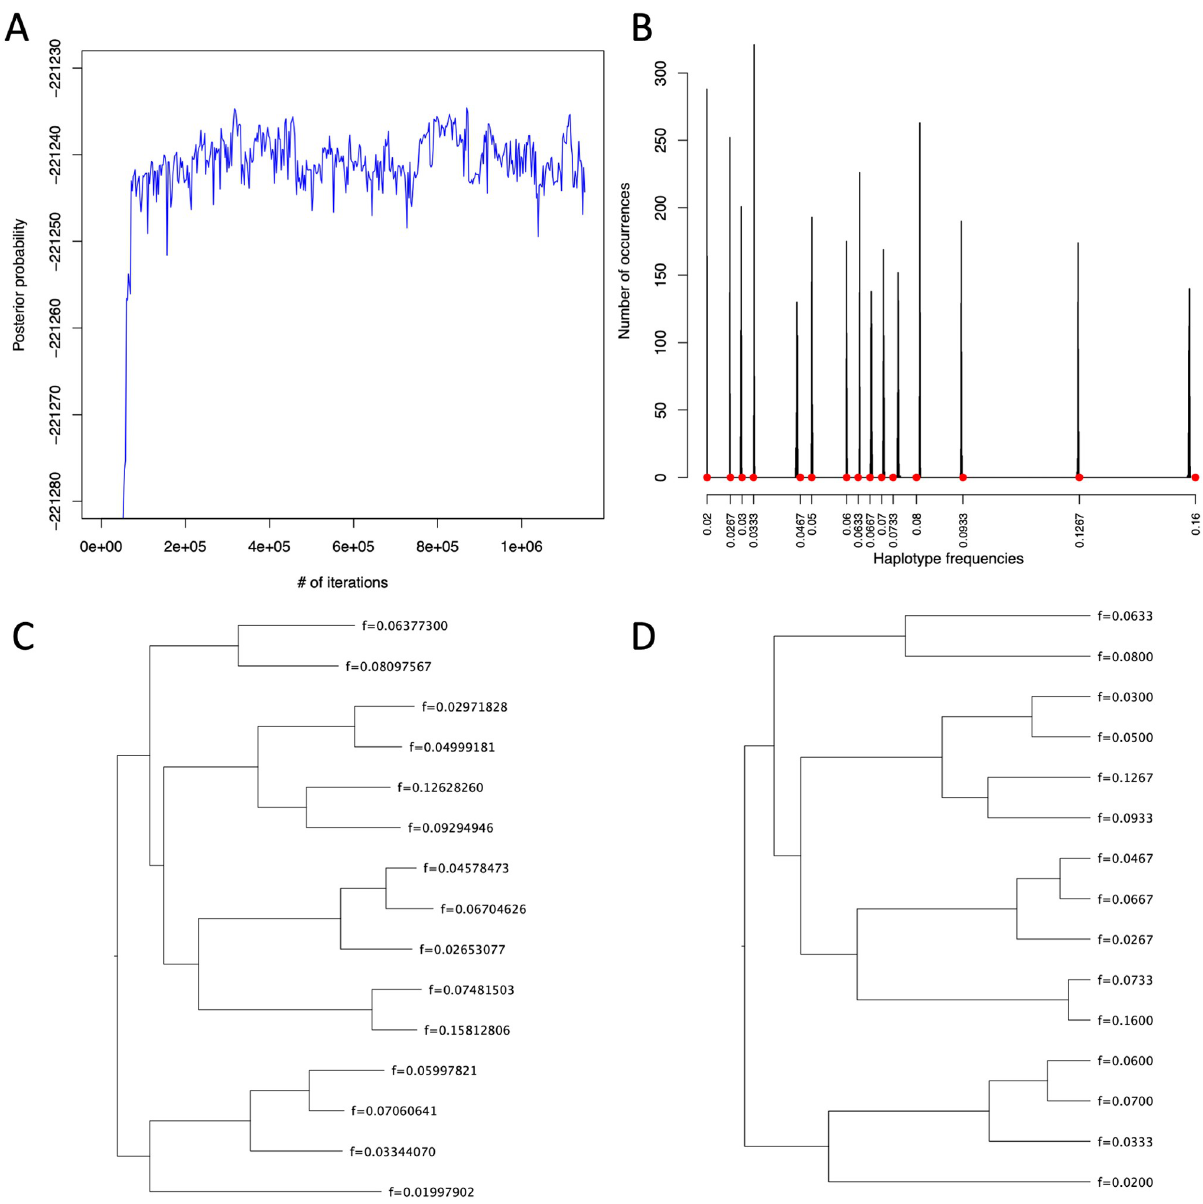
Fig 4. The result of AFPhyloMix on a simulated data set with a mixture consisting of 15 sub-samples. AFPhyloMix was run under the default settings on the read alignments of a simulated mixture of 15 sub-samples in order to estimate the tree topology and the tip relative abundances. (A) The posterior probabilities along the cold chain of MCMCMC process while running the AFPhyloMix, which increased rapidly during the burn-in period and then frustrated steadily over a range of values and was reaching a convergence. (B) The distribution of tip relative abundances (i.e. sub-sample concentration) along the cold chain of MCMCMC process from AFPhyloMix. The actual sub-sample concentrations are marked by the red dots. (C) The tree with tip relative abundances having highest posterior probability along the computation reported by AFPhyloMix. (D) The real tree with the actual sample concentration used for simulating the data